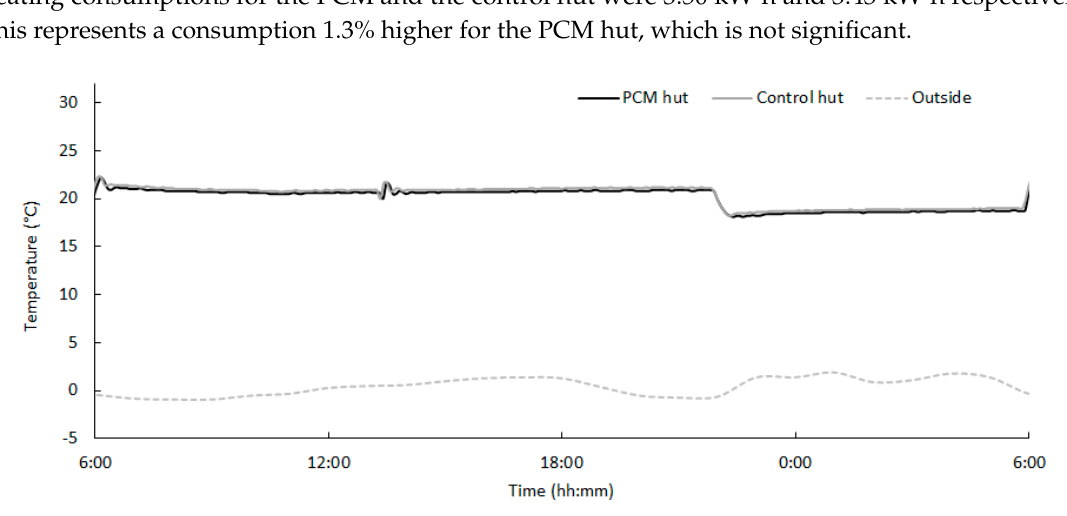
Figure 6. Dry temperature of the huts for a cloudy day of March (15/03/2018).